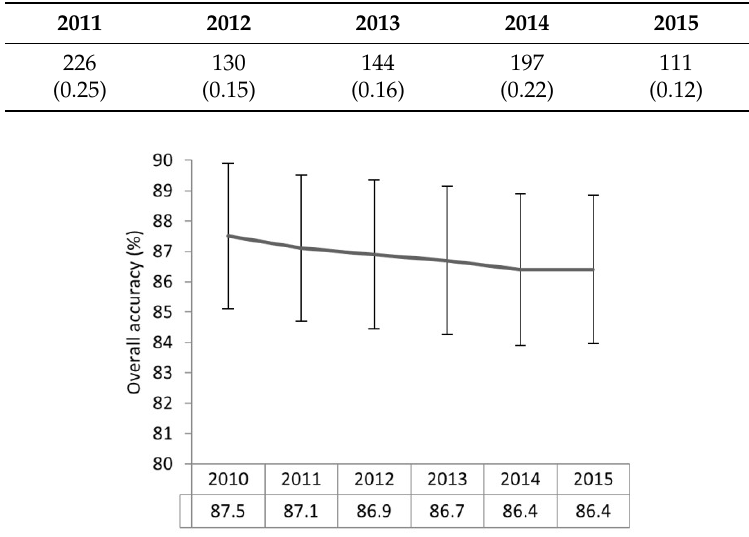
Figure 3. Land cover maps and an example of land cover change (grassland to cropland).